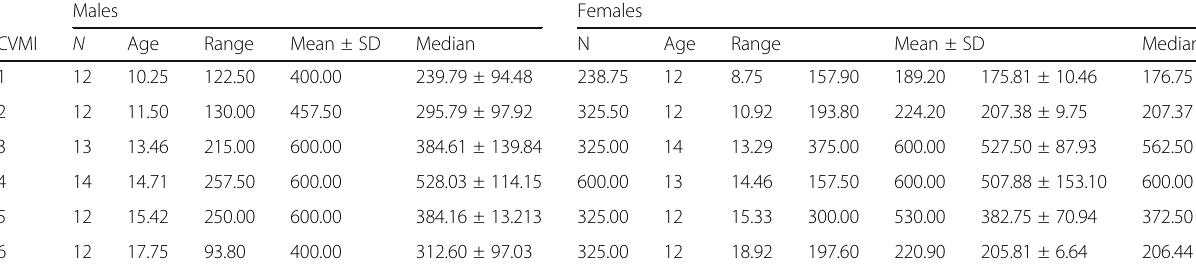
Table 1 Serum IGF-1 (ng/ml) descriptive statistics for each CVMI stage in males and females Males